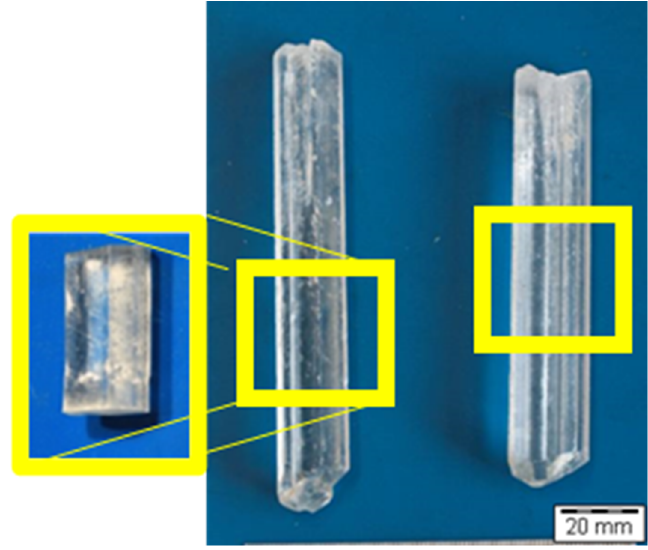
Figure 2. Used natural gypsum crystals (photo).